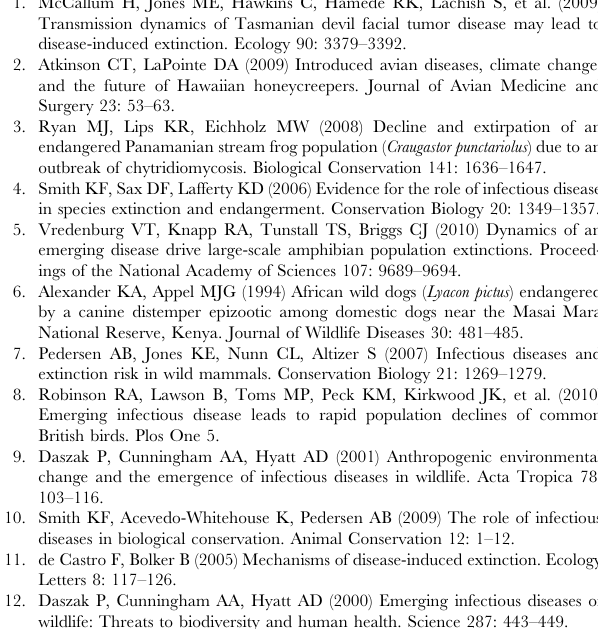
Table S1 Details of the capture occasions of great tits at